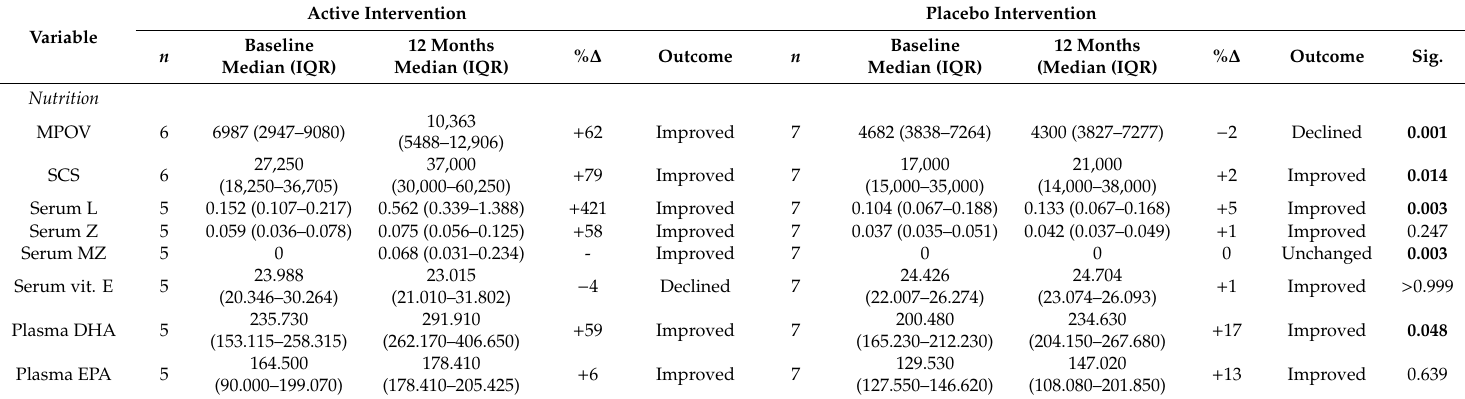
Table 4. Change in nutritional status over 12 months between active and placebo intervention groups.